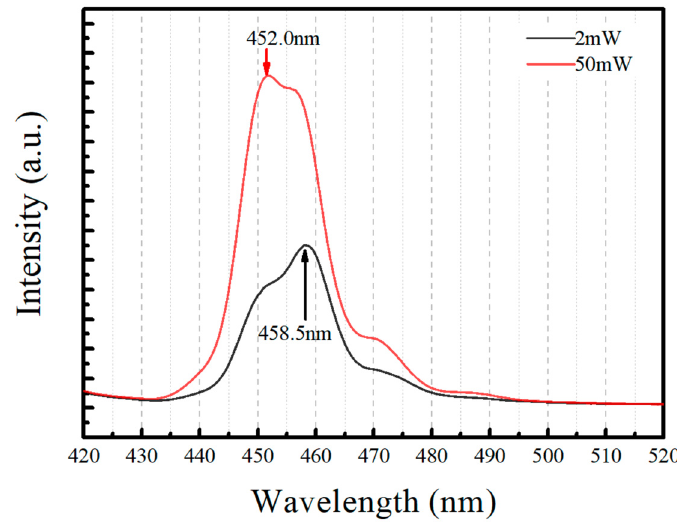
Figure 10. The PL spectra of sample 2QW with 2 and 50 mW excitation laser power under low temperature.